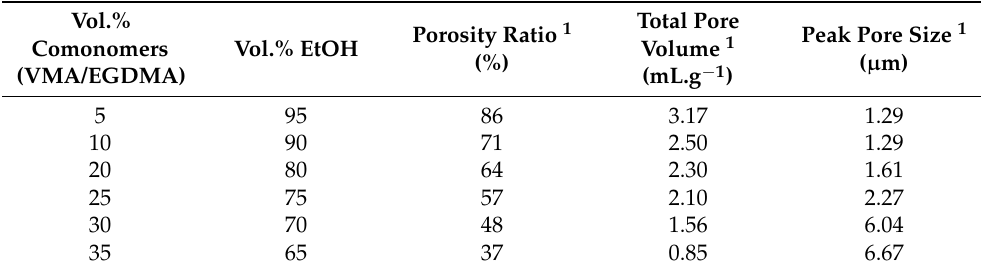
Table 2. Porous features of monoporous VMA-based networks synthesized using various volume proportions of EtOH as the porogenic solvent.